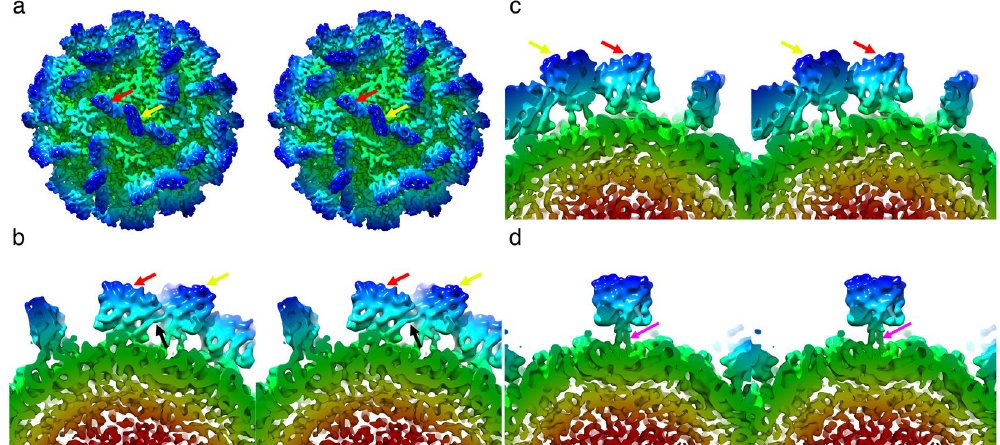
Figure 2. Mr NV particles have pronounced blade-shaped dimeric protrusions. ( a ) Stereo view of the sharpened 3D reconstruction of the Mr NV VLP showing the location of AB (red arrow) and CC (yellow arrow) P-dimers. ( b ) An AB P-dimer (red arrow), viewed parallel to the capsid surface, showing that the protruding spike leans towards the icosahedral two-fold symmetry axis, making contact with the CC-dimer, which is identified by a yellow arrow, the point of contact is highlighted with a black arrow. ( c ) A view of the same AB P-dimer shown in ( b ), but rotated by 180°, highlighting the two-fold symmetry of this feature – a property that is not imposed by the 3D reconstruction process. ( d ) unlike the AB-dimer, the CC dimer is oriented perpendicular to the capsid surface and raised on two clearly resolved legs of density (pink arrow).